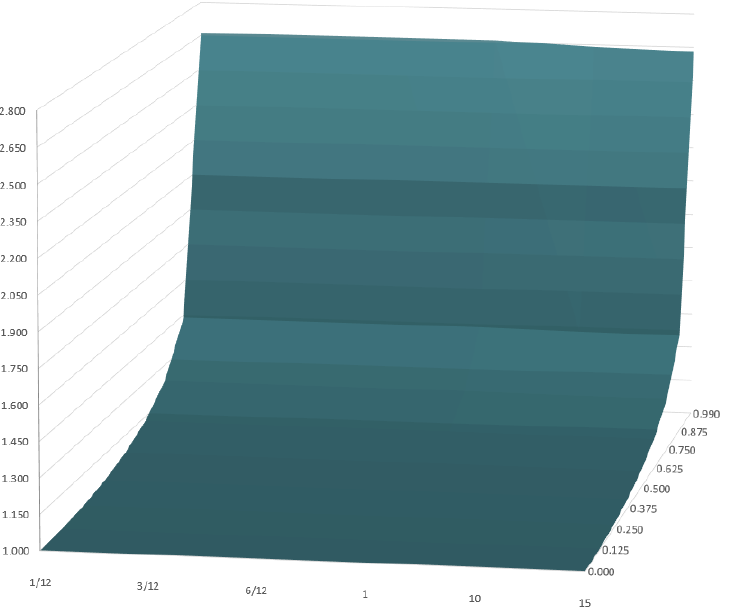
z axis, for velocities ranging Figure 5. Surface of the ratio Call / Call (cid:48) (or Put t / Put (cid:48) t ), displayed on the from 0.0% c to 99% c ( y -axis) and maturities T ( x -axis) of 1/12, 3/12, 6/12, 1, 10 and 15 years. The asset volatility is fixed at σ = 15%. For simplicity, we consider the values at inception t = 0 and r = 0% and both asset prices at inception and strike equal to one S = K =